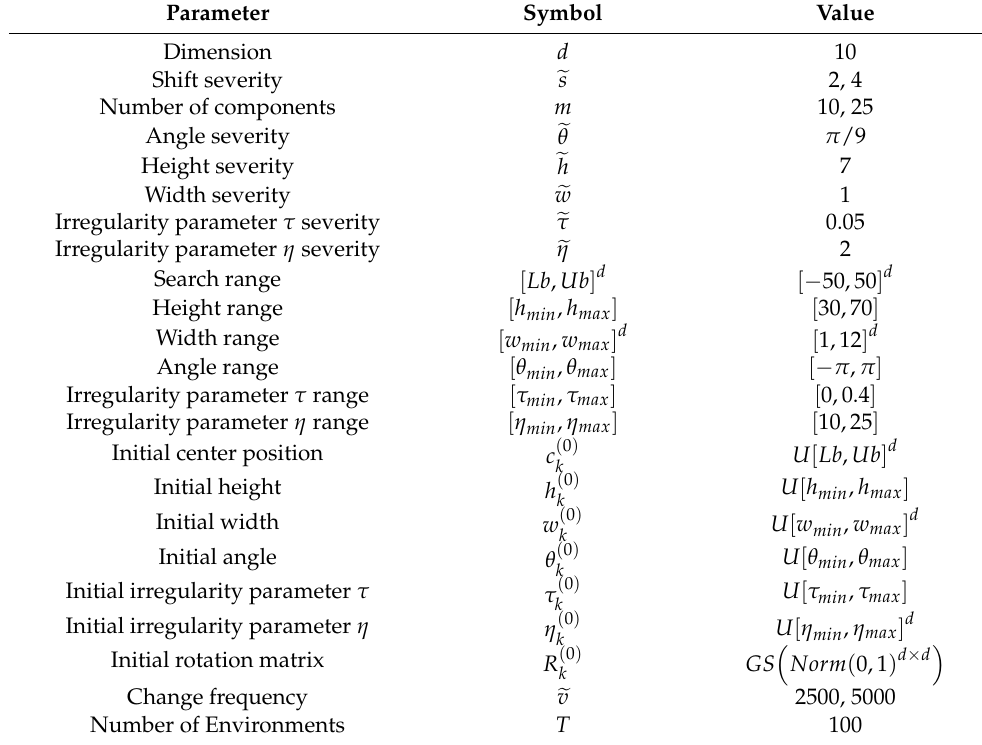
Table 1. The set of Generalized Moving Peaks Benchmark (GMPB) parameters.